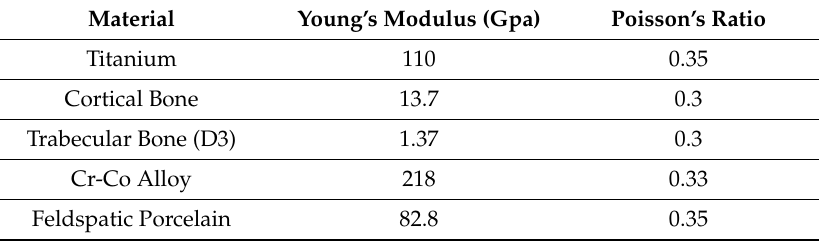
Table 1. Mechanical properties of materials